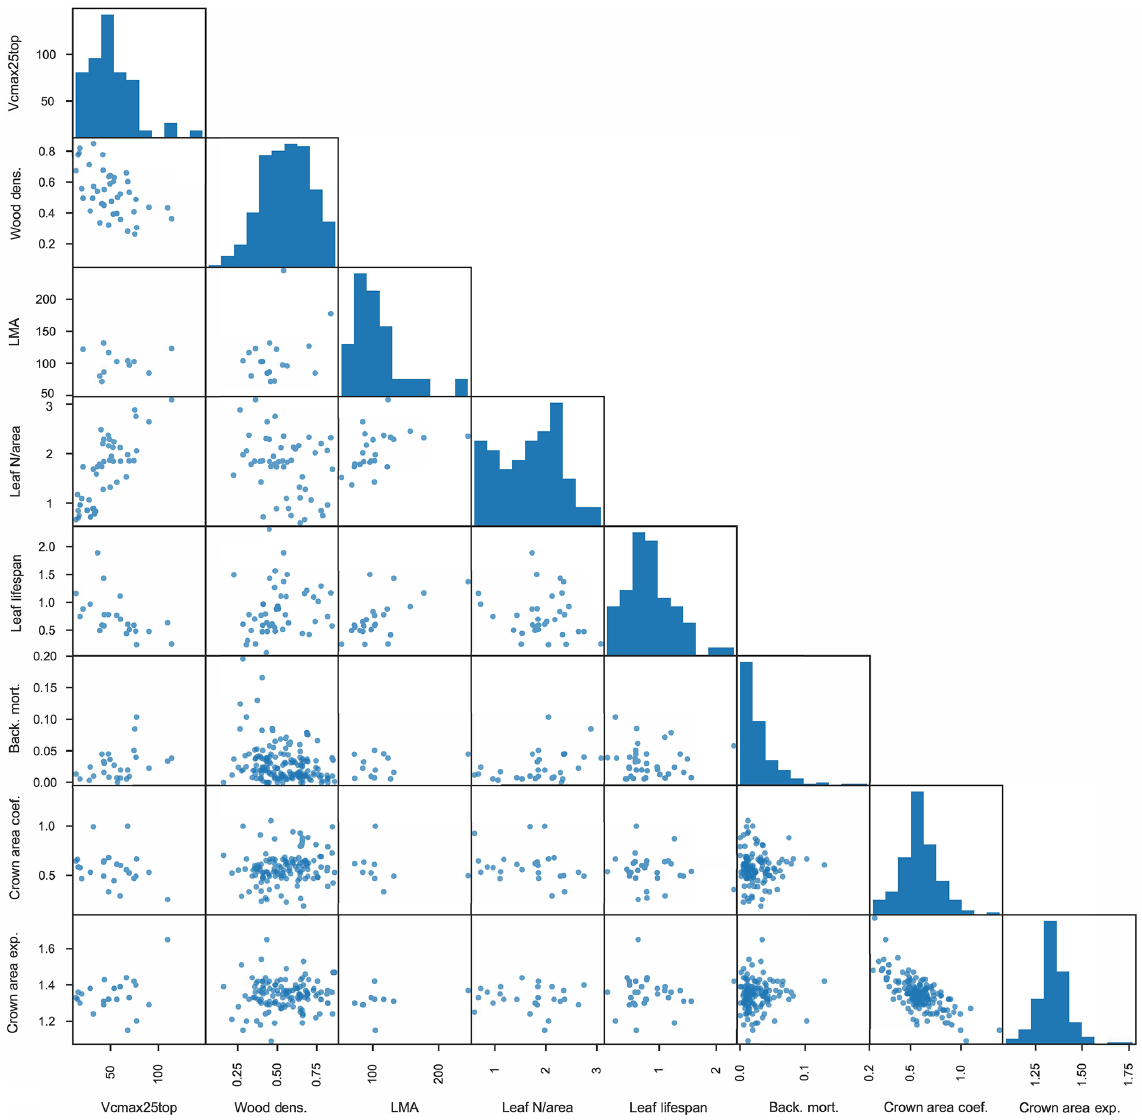
Figure 3. Matrix of plant trait data used to inform FATES ensembles. Measured traits are as follows: leaf V c , max , 25 , top (µmolCO 2 m − 2 s − 1 ), wood density (gcm − 3 ), leaf mass per unit area (m 2 g − 1 ), leaf N per unit area (gm − 2 ), leaf lifespan (year), plant mortality rate (yr − 1 ), coefficient of relationship of crown area to stem diameter (m 2 cm − 1 ), and exponent of relationship of crown area to stem diameter (unitless). Each dot represents one pair of species-level trait values where both traits are measured for a given species; histograms show the distributions of all species-level values for a given